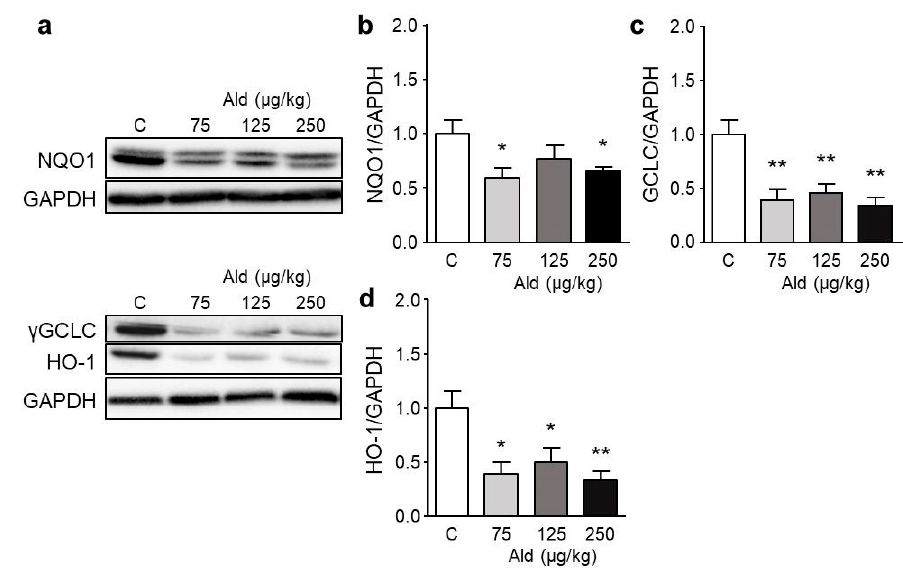
Figure 8. Expression of Nrf2-regulated proteins in aldosterone-infused mouse kidneys. ( a ) Representative pictures of Western blots of the expression of NQO1 (31 kDa), γ GCLC (73 kDa), and HO1 (32 kDa) in kidneys of mice. Panels ( b – d ) show the quantification of band densities of the above-mentioned proteins measured via image J and related to the housekeeper GAPDH (37 kDa). Ald: aldosterone, GAPDH: glyceraldehyde 3-phosphate dehydrogenase, γ GCLC: γ -glutamate cysteine ligase catalytic subunit, HO-1: heme oxygenase 1, NQO1: NADPH quinone dehydrogenase 1. Data are shown as mean + SEM, n = 5. * p ≤ 0.05, ** p < 0.01 vs. control group (C).